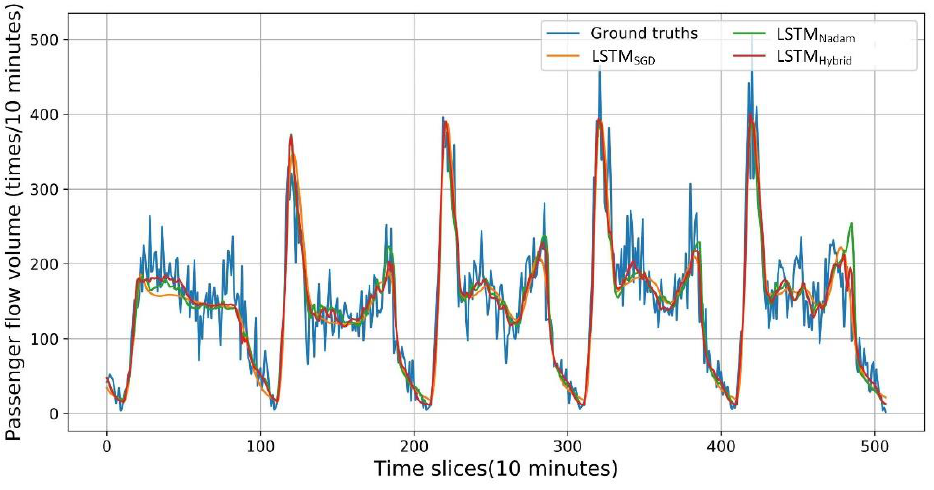
Figure 12. Comparison of the prediction performance s of Licun Park.